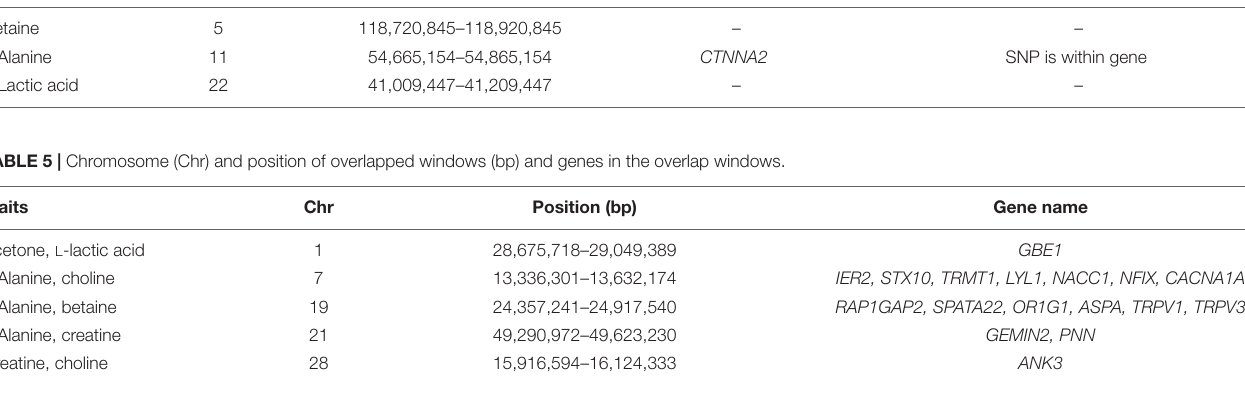
TABLE 4 | 200-kpb regions around the significant SNPs: chromosome (Chr), position of the region on chromosome (bp), gene in the regions and the location of the gene compared to SNP location. Trait Chr Position (bp)